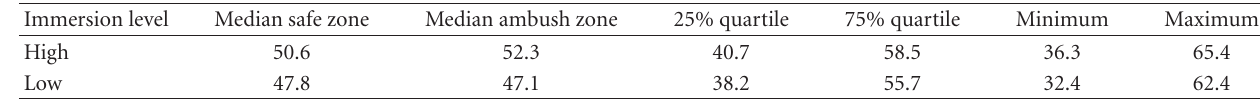
Table 1: Distribution statistics for EMG eyeblink results.